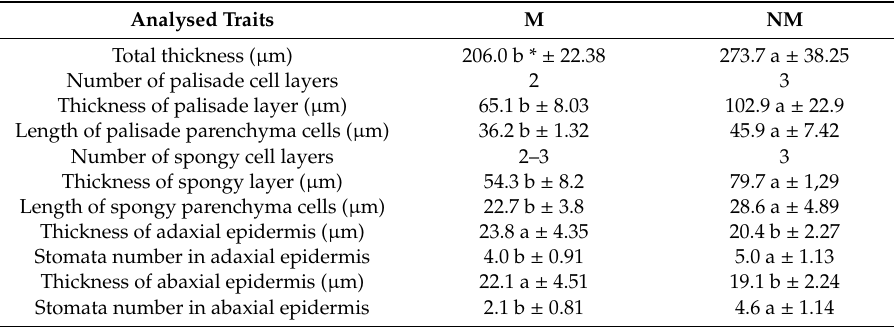
Table 2. Anatomical characteristics of leaves of different Anthyllis ecotypes .